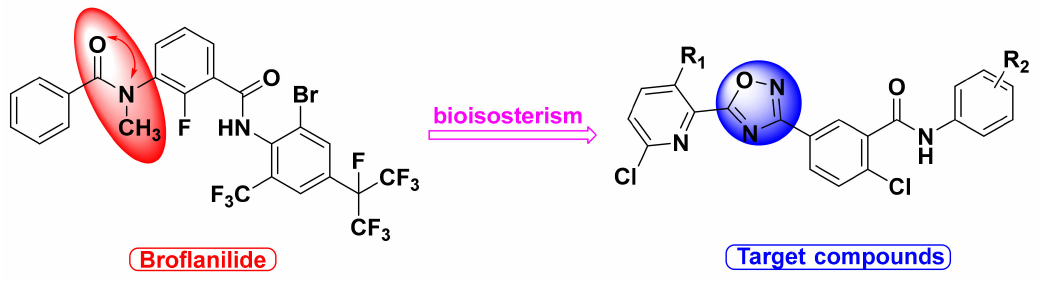
Figure 2. Design strategy of target